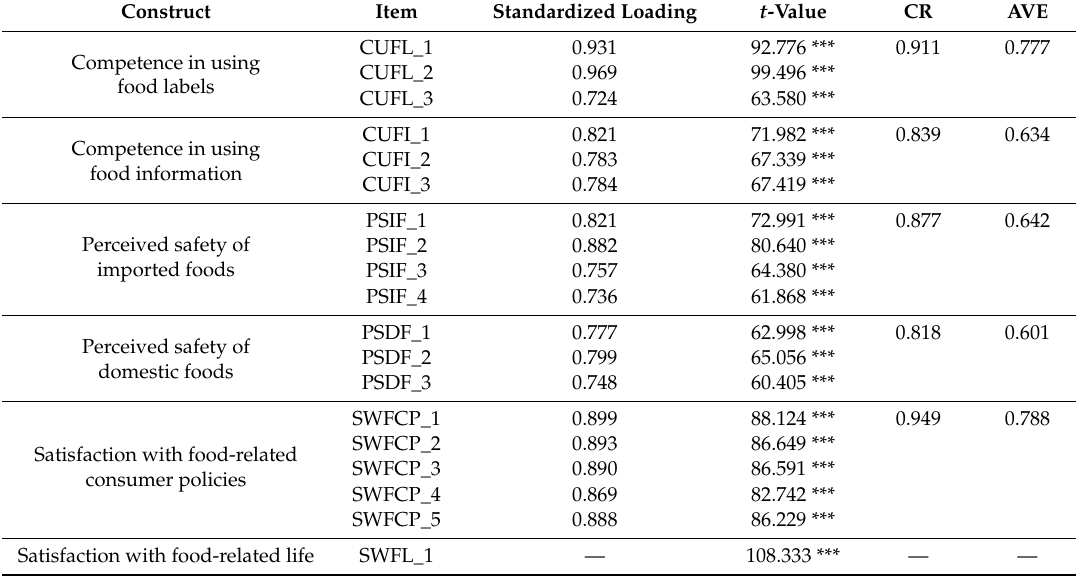
Table 3. Analysis of the measurement model.